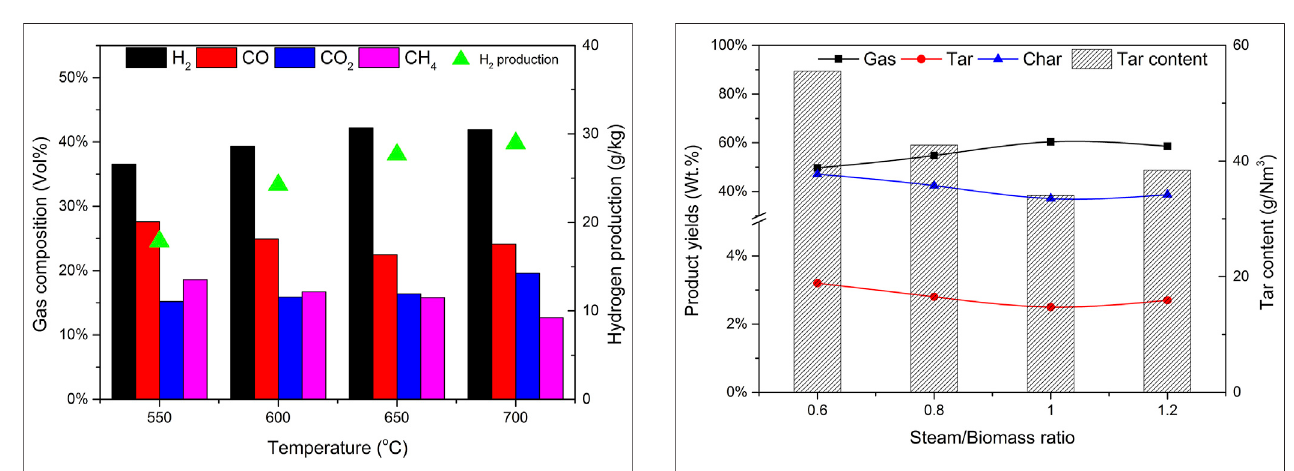
FIGURE 12 | Effect of SBR on product yields and tar content.